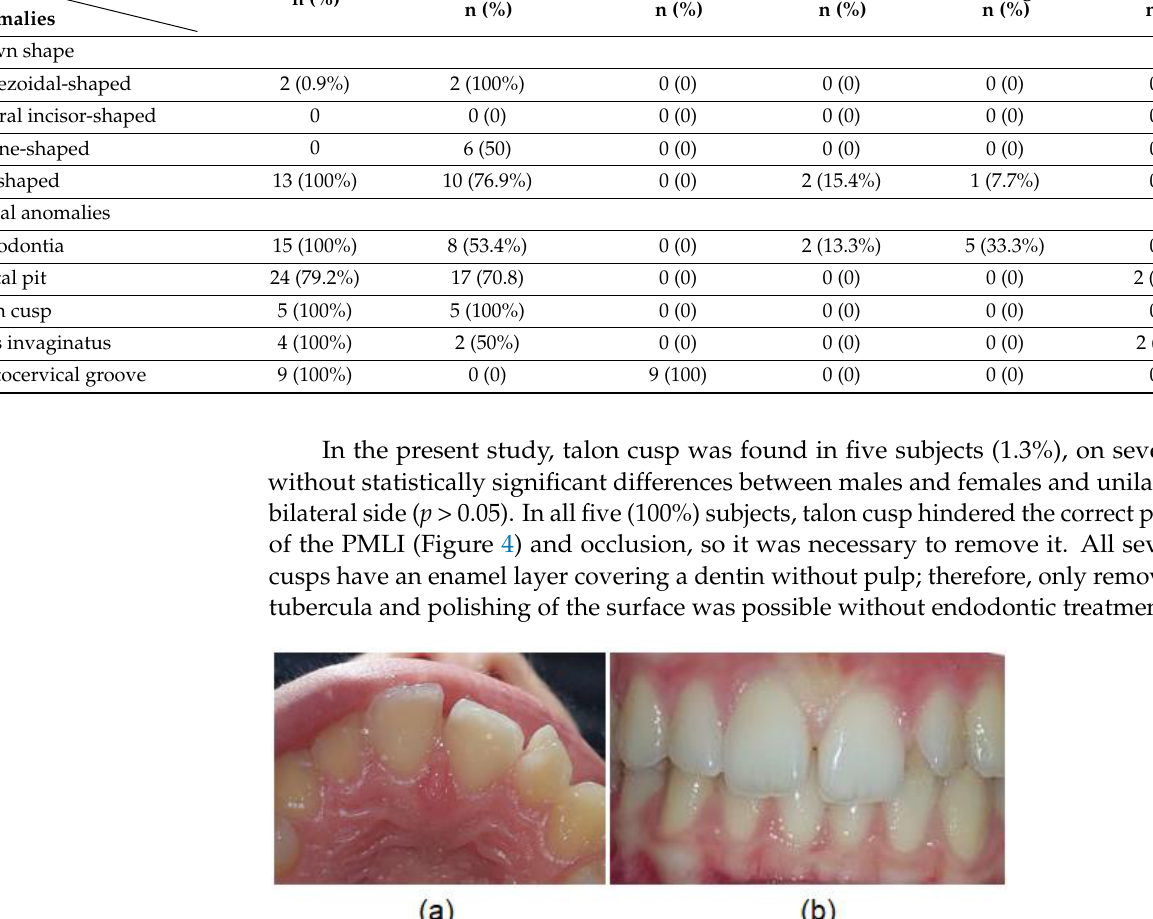
Table 3. The distribution of additional specialists included in subjects ’ treatment according to crown shapes and affiliated anomalies.